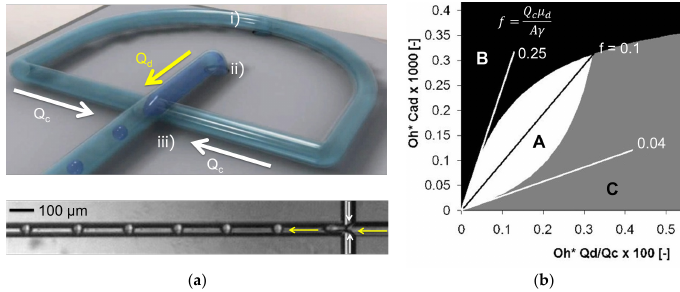
Figure 4. The microfluidic system. ( a ) (top) Schematic 3D picture of droplet formation showing the arrangement of the two inlet tubes: (i) continuous phase inlet that then splits into two tubes; (ii) dispersed phase inlet; (iii) mixing head. (bottom) High-speed microscope image of the single-channel production window. ( b ) Flow map, depicting all combinations of liquid properties, microchannel size and flow rates. Combinations in the white area (region A) yield the desired process, i.e., spherical particles; combinations in the black area (region B) lead to instabilities and non-uniform droplets; and, in the grey area (region C), to droplets larger than the exit channel.